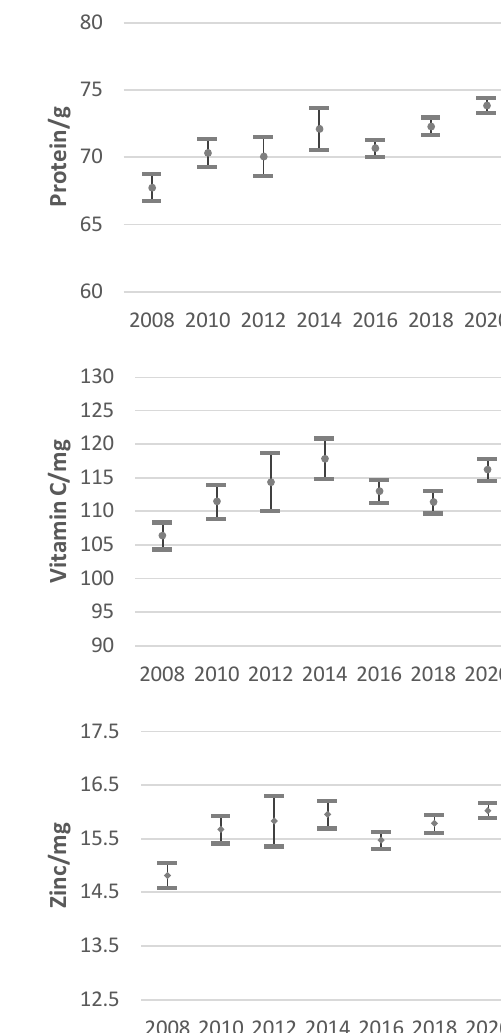
Figure 1. Daily nutrient availability per equivalent adult, 2008–2020. Confidence intervals at 95%. Source: Authors’ elaboration using data from the ENIGH [21] and the data set of nutrient availability elaborated by the authors.